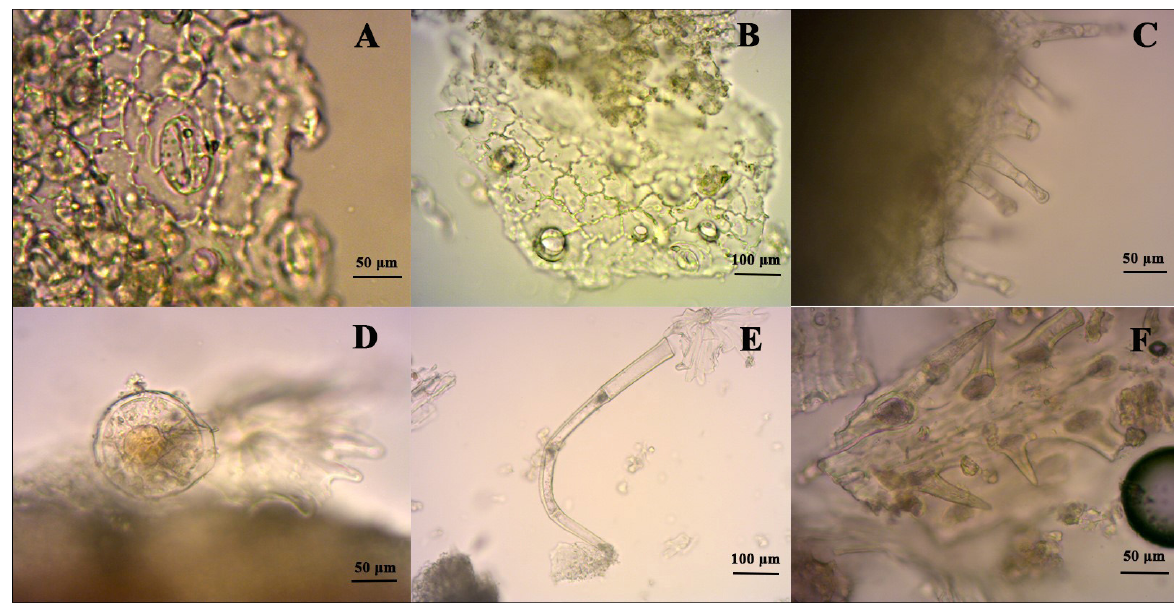
Figure 1. Microscopic characteristics of the oregano herb. ( A ) Stomata, magnification: 40×; ( B ) Epidermis, magnification: 20×; ( C , D ) Glandular trichomes, magnification: 40×; ( E ) Multicellular covering trichome, magnification: 20×; ( F ) Unicellular covering trichome, magnification: 40×